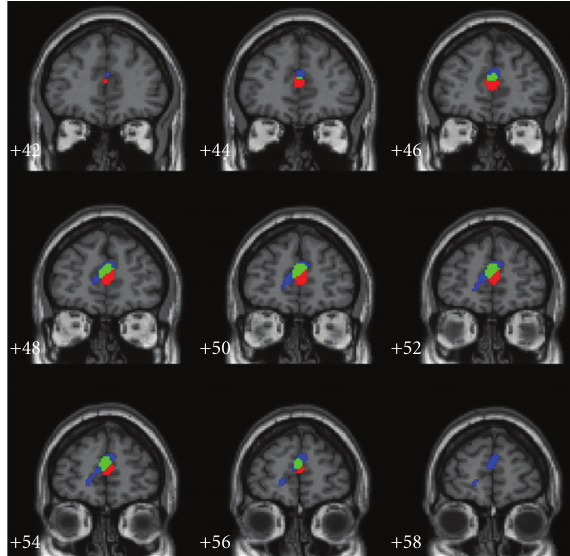
Figure 1: Dorsomedial prefrontal area in which greater regional cerebral blood flow post-treatment related to either better blood pressure decrease (red), poorer post-relative to pretreatment work- ing memory performance (blue), or both (green). See details and relevant review [28,